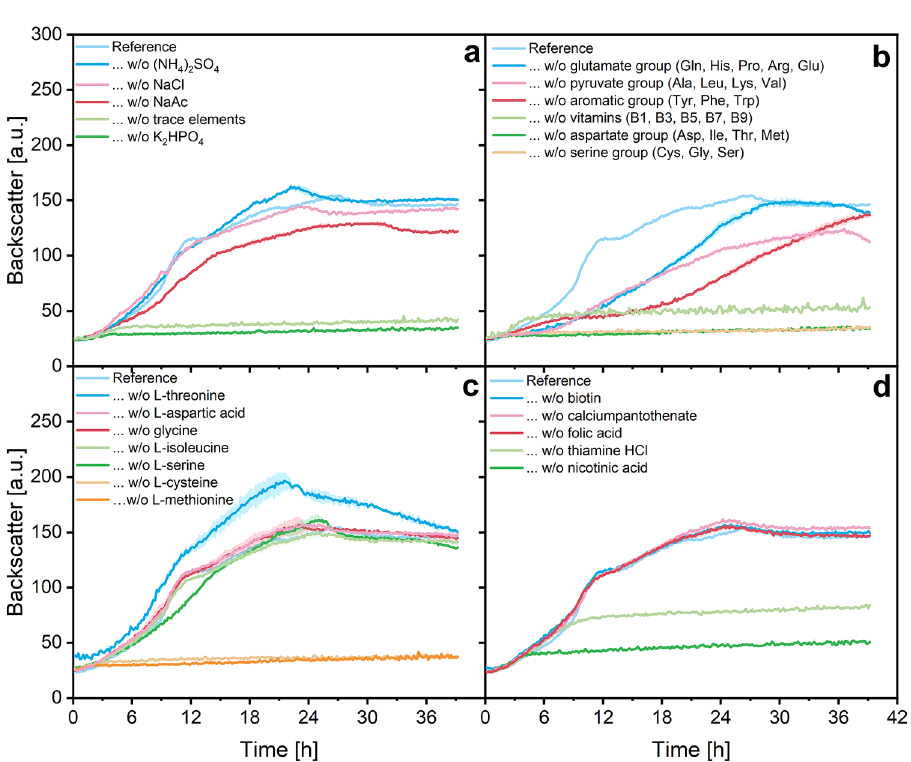
Figure 1. Backscatter data from a microplate cultivation of S. pasteurii in modified chemically defined media to determine nutritional requirements and auxotrophic deficiencies. Illustrated are backscatter data from different growth curves after leaving out grouped or single components from the chemically defined medium (Table 1). Culture conditions: 48-well Flower Well Plate, filling volume 800 µ L, shaking frequency 1200 rpm, shaking ◦ diameter 3 mm and temperature 30 C. Here, arithmetic mean values derived from biological replicates (N = 2, N = 1 for w/o vitamins) are shown. The error bands depict the standard